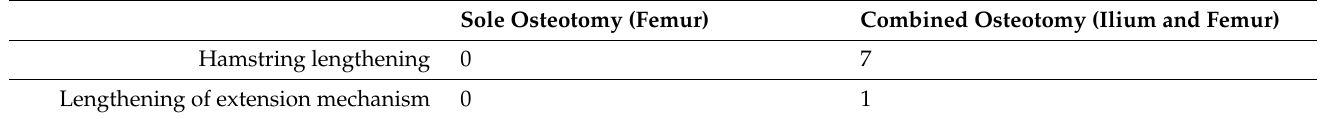
Table 2. Cont. Sole Osteotomy (Femur) Combined Osteotomy (Ilium and Femur) Hamstring lengthening 0 7 Lengthening of extension mechanism 0